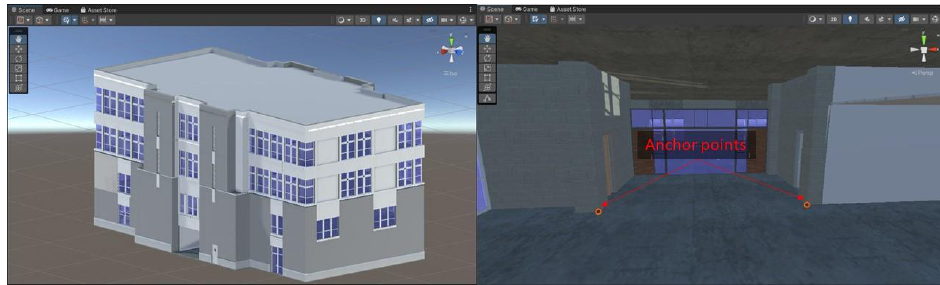
Figure 12. BIM model (left) of use case 1 and selection of anchor points (right).